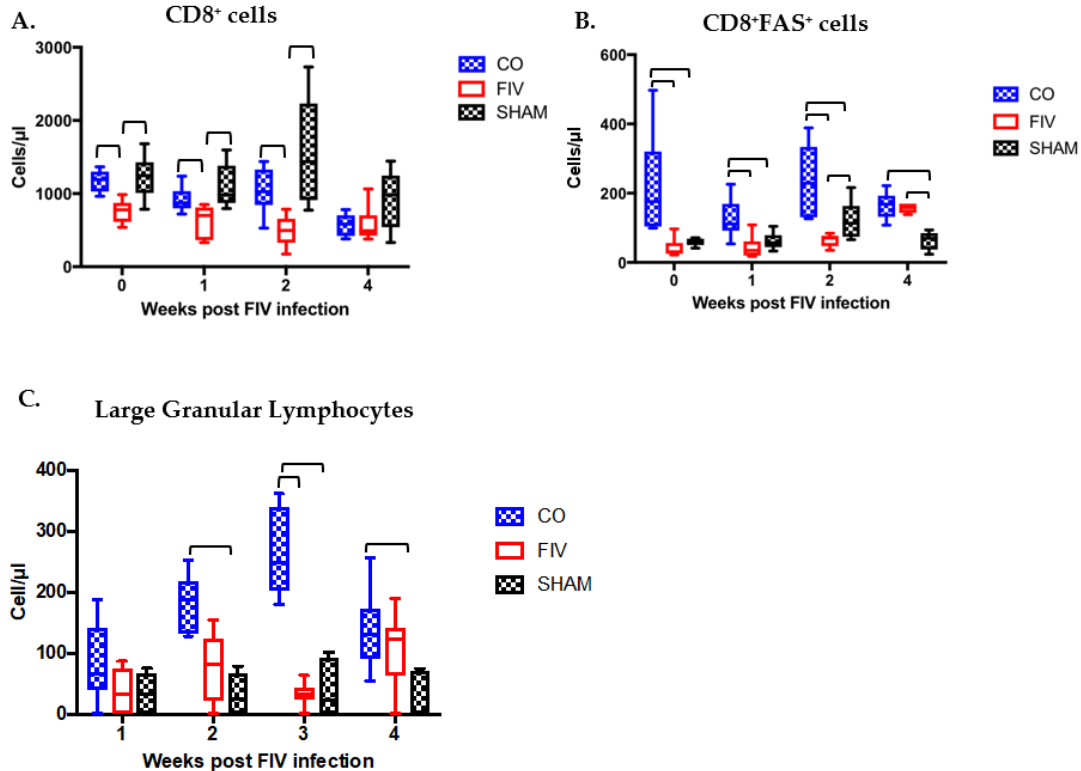
Figure 4. CD8 + cells are higher in the blood of CO compared with FIV cats at 0, 1 and 2 weeks FIV ‐ PI ( P = 0.0015, P = 0.045, P = 0.011, respectively). CD8 + cells in CO cats are similar to SHAM cats at all time points ( P > 0.05), whereas FIV cats had decreased levels compared with SHAM cats at 0, 1 and 2 weeks FIV PI ( P = 0.005, 0.0136, and 0.003, respectively) ( A ). CD8 + FAS + cells in the CO cats were higher than SHAM cats at all of the time points (0 week, P = 0.00098; 1 week, P = 0.0198; 2 weeks, P = 0.0292; 4 weeks, P = 0.00135), and higher in FIV as compared with SHAM cats at 2 and 4 weeks FIV PI ( P = 0.02577, 0.00088, respectively) ( B ). Large granular lymphocyte (LGL) numbers mirrored the CD8 + FAS + cell populations, and differences were trending at one week ( P = 0.074) and were significant at two weeks ( P = 0.002) FIV PI between CO and FIV cats. Significant differences in LGLs were trending at one week ( P = 0.074) and were significant at two weeks FIV PI in between the CO and FIV cats ( P = 0.002). LGLs were higher in the CO than SHAM cats at 2, 3, and 4 FIV PI ( P = 0.0076, 0.0059, and 0.0044, respectively). However, no significant difference was found in LGL numbers between the FIV and sham inoculations of media (SHAM) cats at any time point ( C ). Bars indicate statistical differences between the indicated groups. Significant differences were also noted among the three groups over time (CD8 + cells, P = 0.0005; CD8 + FAS + cells, P = 0.0004; LGLs, P = 0.003).